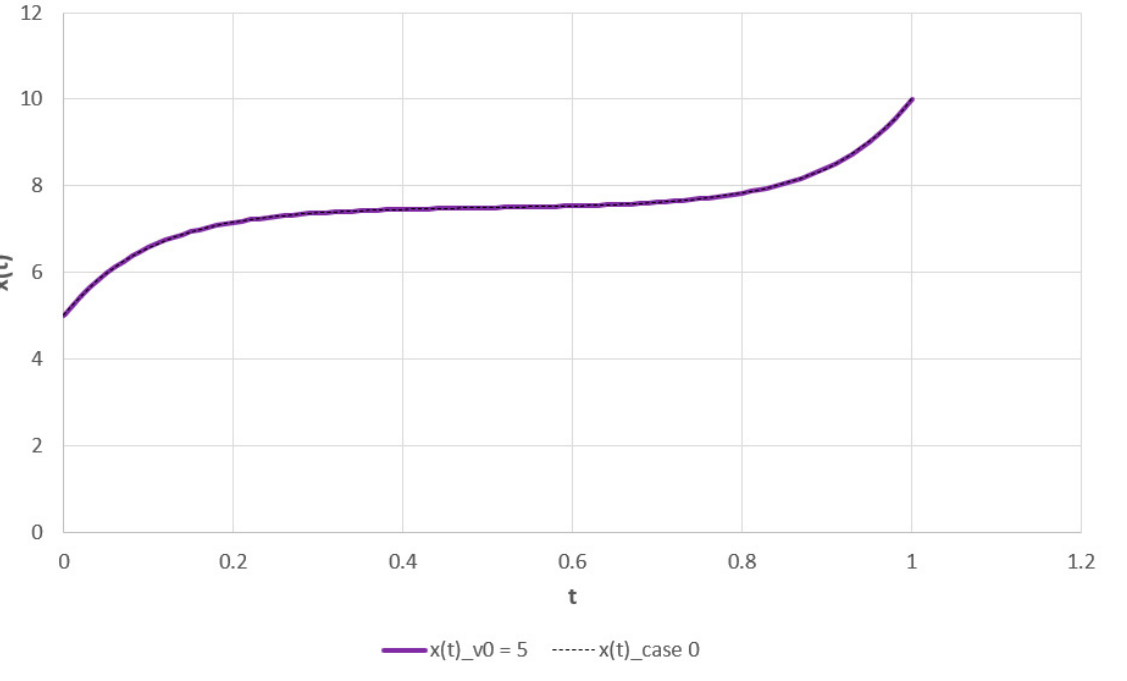
Figure 18. The optimal time path of x in Dynamic case 4.